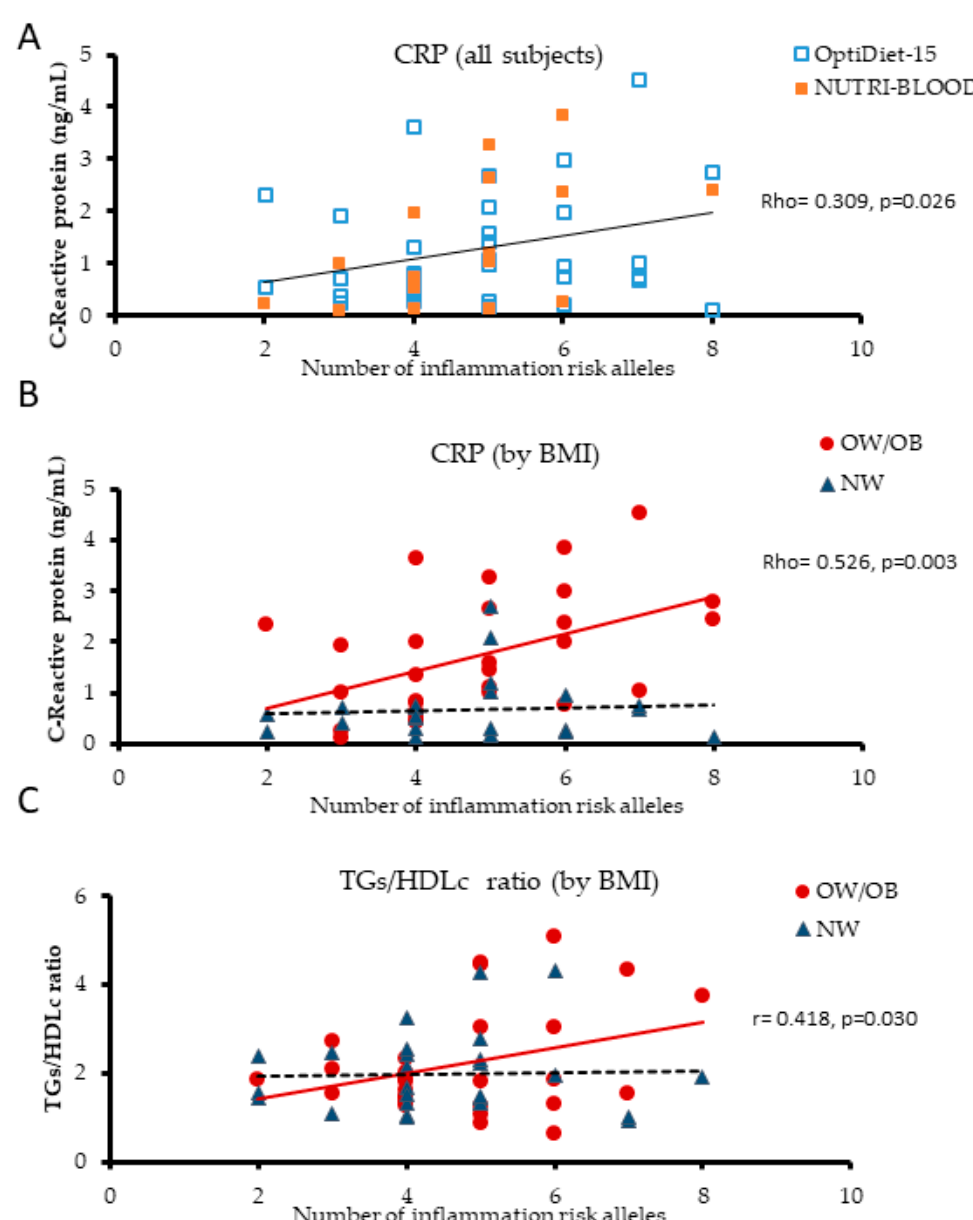
Figure 3. Linear correlation between plasma biomarkers and LGI-Ob genetic score. Relationship between C-reactive protein (CRP) and LGI-Ob genetic score in subjects classified by ( A ) source of study and ( B ) BMI: Normoweight (NW, BMI < 25); overweight/obese (OW/OB, BMI ≥ 25) ( n = 52). ( C ) Relationship between triglycerides-to-HDLc (TGs/HDLc) ratio and LGI-Ob genetic score in subjects grouped by BMI ( n = 55). Spearman and Pearson (adjusted by age) correlation analysis were applied. Rho: Spearman’s correlation coefficient; r : Pearson’s correlation coefficient. Data belong to both NUTRI-BLOOD ( n = 18) and OptiDiet-15 ( n = 41)